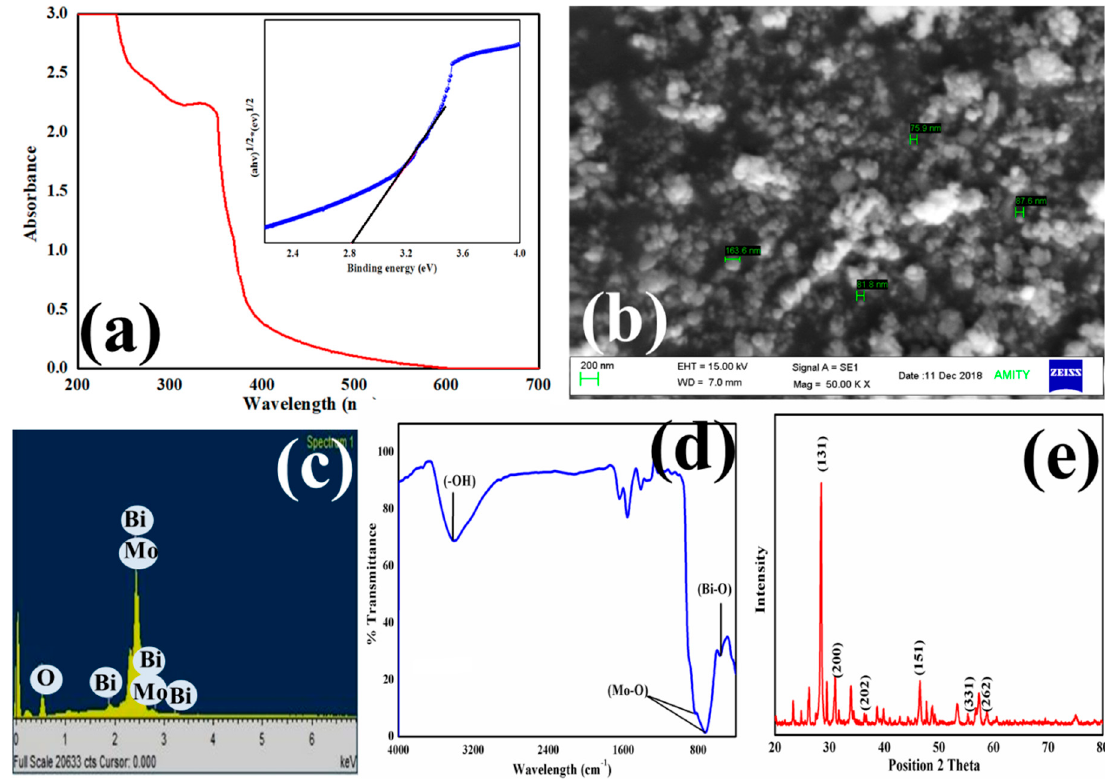
Figure 2. ( a ) UV-Visible analysis (Tauc’s plot inset) ( b ) SEM, ( c ) EDS, ( d ) FTIR and ( e ) XRD analysis of the photocatalyst.